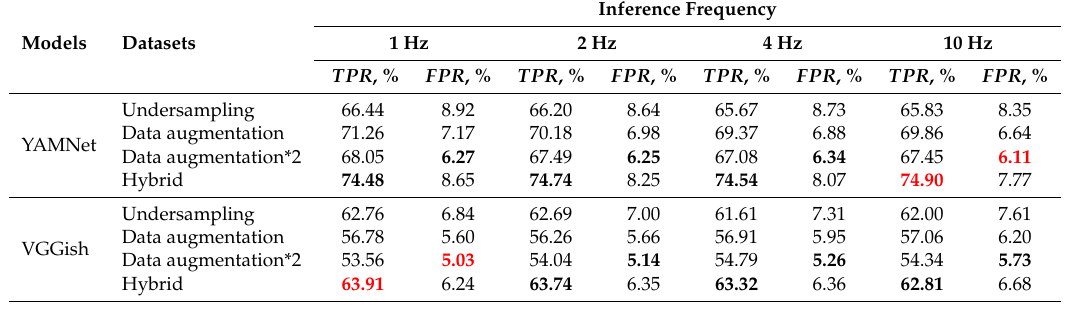
Table 3. YAMNet and VGGish performance according to TPR and FPR , expressed as a percentage, for four datasets and four inference frequencies.